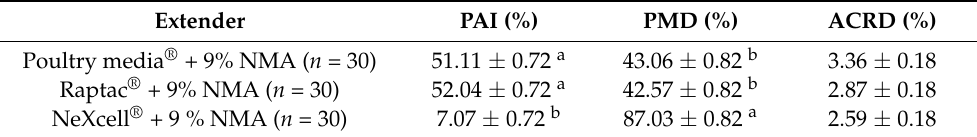
Table 3. Impact of semen extender supplemented with defined cryoprotective agent on the plasma membrane and acrosome intactness (PAI), plasma membrane damage (PMD) and acrosome dam- age (ACRD) of thawed rooster sperm (least square means ± standard error).